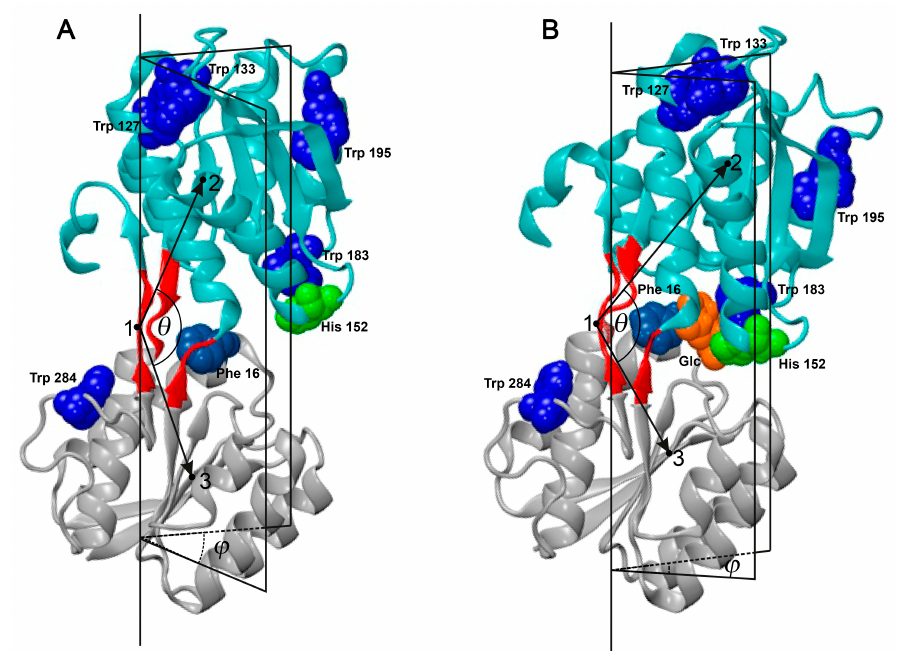
Figure 1. The 3D structure of D -glucose/ D -galactose-binding protein (GGBP). Cartoon represents the 3D structure of GGBP constructed on the basis of X-ray data (PDB IDs: 2FW0 and 2FVY) [28]. N- and C-terminal domains are given in cyan and gray, protein hinge region is given in red. Tryptophan residues, Phe16, His152 (6-bromoacetyl-2-dimetylaminonaphtalene (BADAN) linked to position 152 when His is changed to Cys) and glucose are shown in space-filling diagram in blue, light blue, green, and orange, respectively. θ is an angle between the vectors directed from the mass center of the hinge region (point 1) to the mass centers of the C- and N-terminal domains (points 2 and 3). φ is a dihedral angle between the planes formed by strait line passing through two endpoints of the hinge region and the mass centers of the C- and N-terminal domains (points 2 and 3). Panel ( A ) represents structure of the apo-form of GGBP, whereas Panel ( B ) shows structure of the holo-form of this protein. The GGBP active center is located in the cleft between these domains and is formed by residues Trp183 and Ala16, which, when stacked with sugar molecules, make the most dominant contribution to the interaction of this protein with a ligand [29,30].